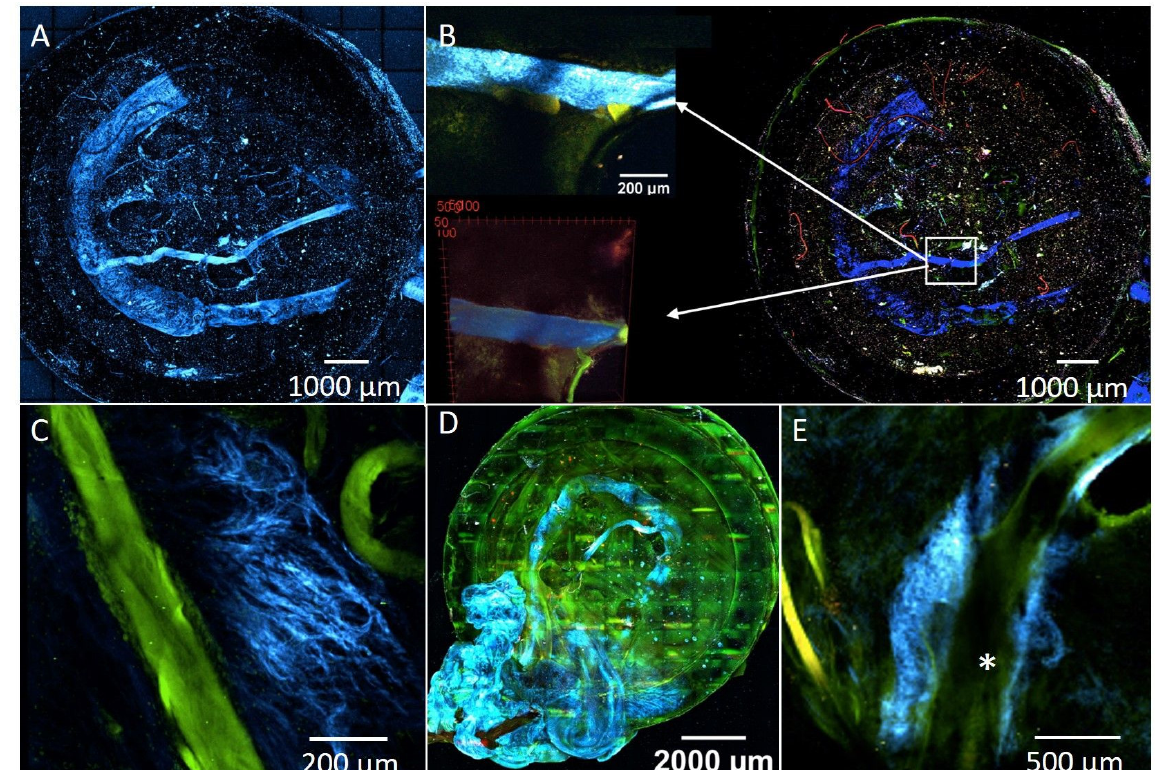
Figure 9. Color pattern: Blue indicates the SHG signal of collagen in vascular and nerve structures. Green and red represent the tissue autofluorescence. ( A ): EPI loop PC construct with subsequent explantation. Strong signal of motor nerve branch and vessels in SHG channel; ( B ): Positive signal of motor nerve branch in SHG channel; ( C ): newly formed capillaries (blue) in PC4; ( D ): Visualization of the EPI loop model (PCP) after four weeks of implantation; ( E ): Neoangiogenesis (blue) in the area of the EPI loop (indicated by (*)).